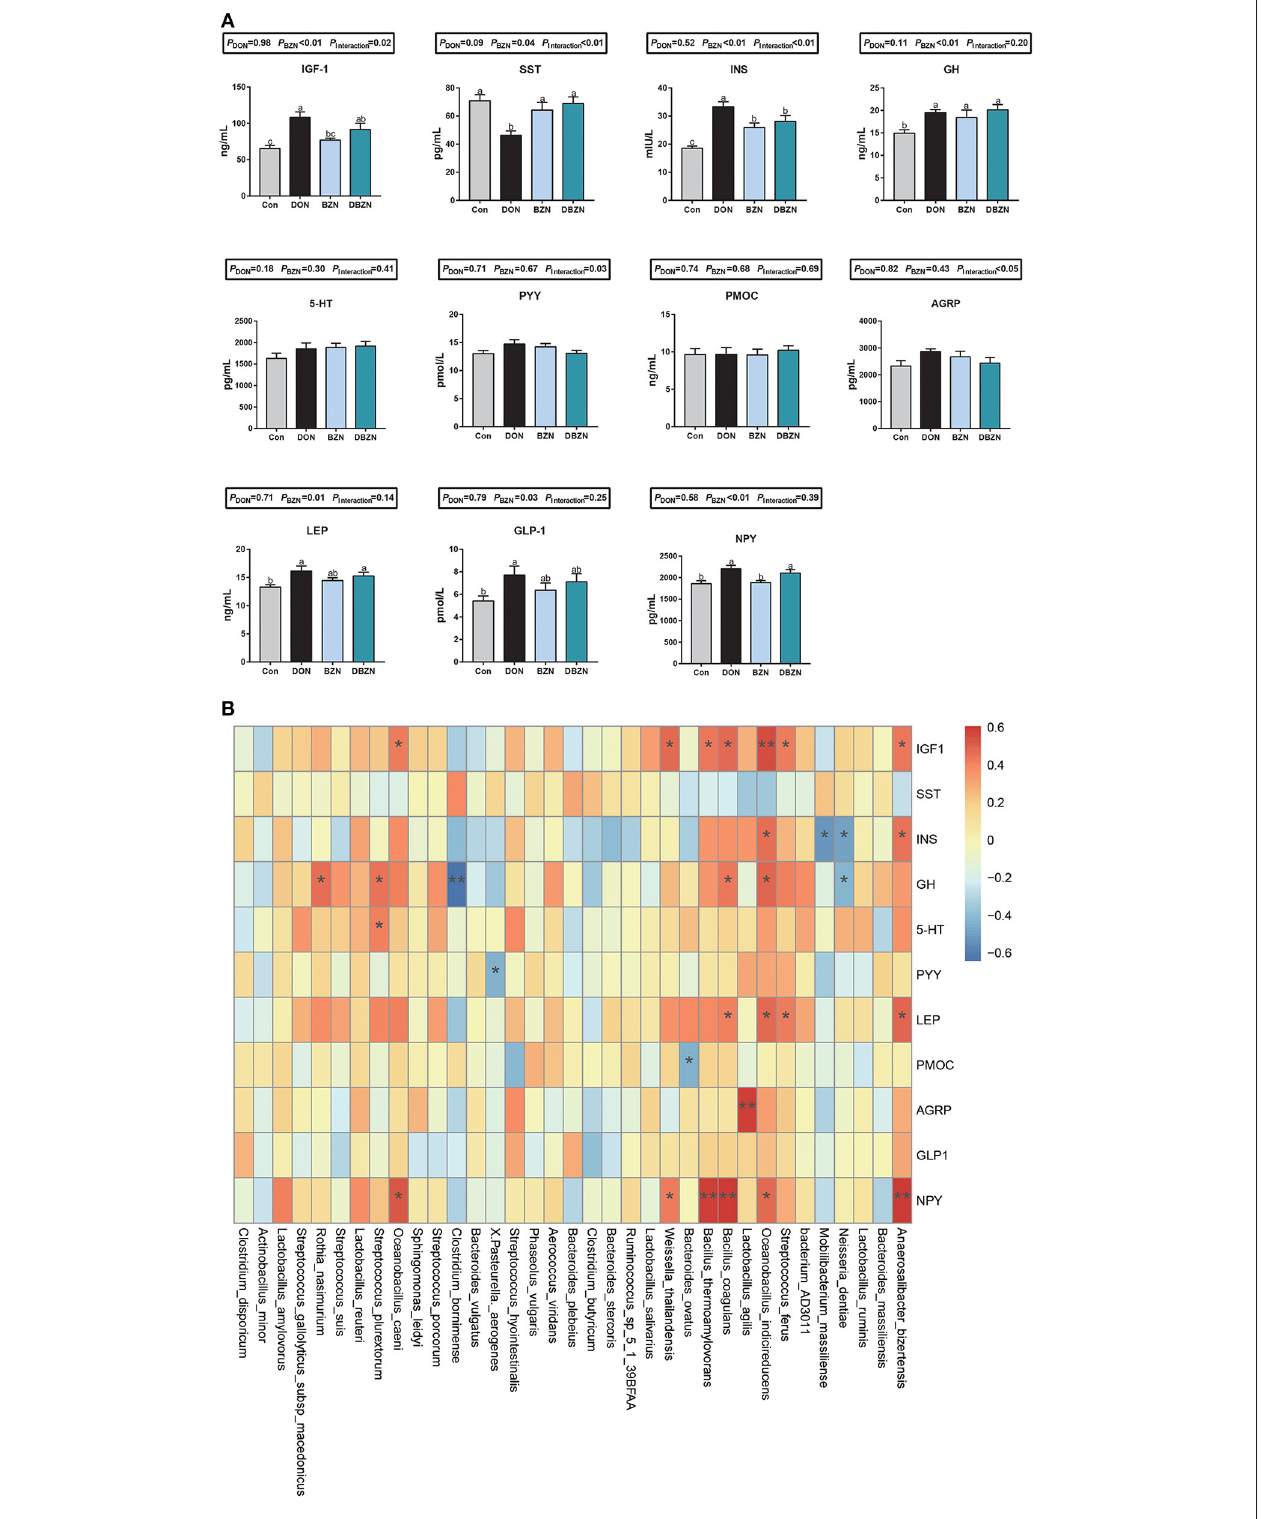
FIGURE 5 | BZN- and DON-mediated hormone secretion and correlations with gut microbiota. (A) The concentration of serum hormone. (B) The Spearman correlations between the gut microbiota and serum inflammatory makers. * p < 0.05, ** p < 0.01. Dietary treatment: Con, basal diet; DON, 4 mg/kg DON-contaminated diet; BZN, 0.5% BZN supplementation diet; DBZN, 0.5% BZN supplement in 4 mg/kg DON-contaminated diet. IGF1, insulin-like growth factor 1; NPY, neuropeptide Y; SST, somatostatin; INS, insulin; GH, growth hormone; 5-HT, 5-hydroxytryptamine; PYY, peptide YY; PMOC, proopiomelanocortin; AGRP, agouti-related protein;